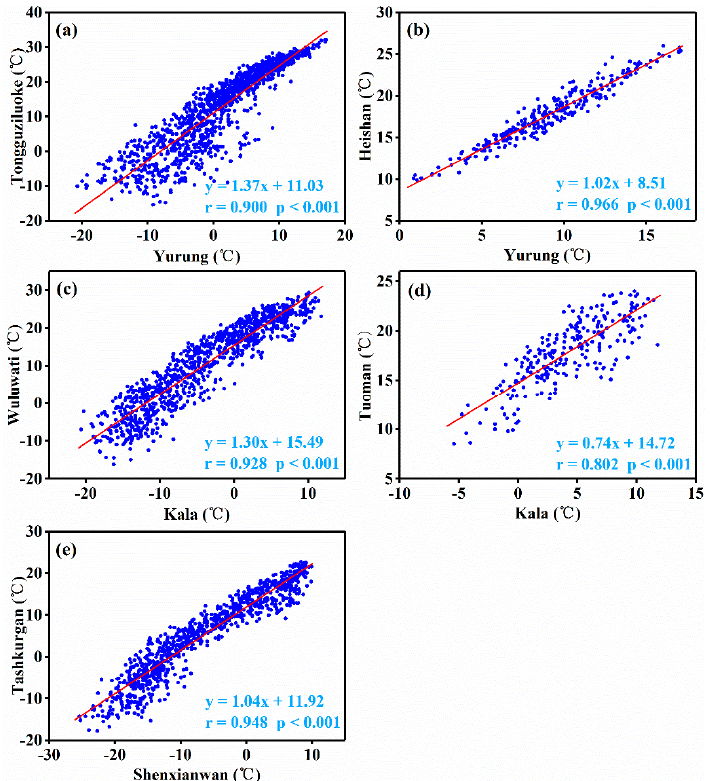
Figure 2. Correlation of daily temperature between hydrological or meteorological stations in mountainous areas and adjacent AWSs at high altitudes. ( a ) Yurung and Tongguziluoke, ( b ) Yurung and Heishan, ( c )Kala and Wuluwati ( d ) Kala and Tuoman, ( e ) Shenxianwan and Tashkurgan. There are few hydrological and meteorological stations in the mountainous study area.